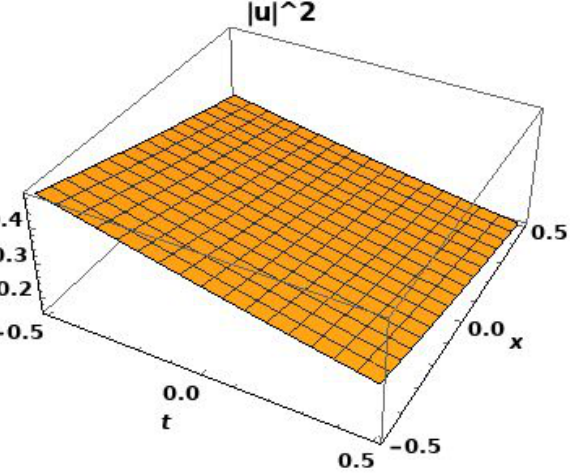
Fig. 2 3D-plot for | v ( x , y , t ) | 2 when y = 0 where µ = − 1, λ = 1, γ solution)